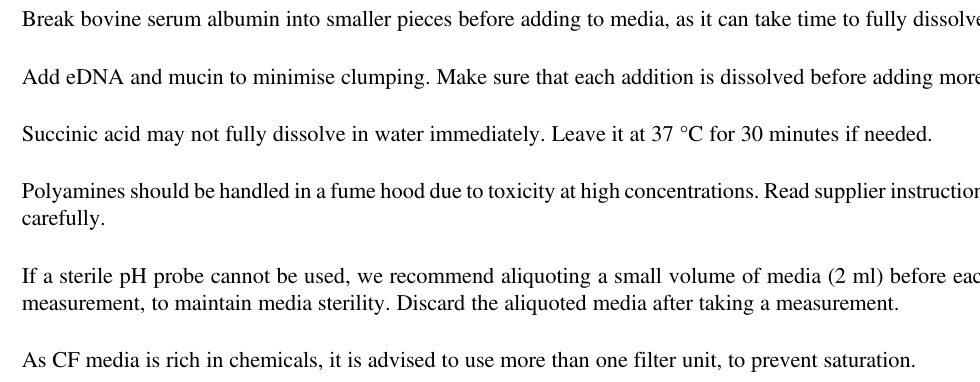
Table 13. Conditions of 5% CO 2 can be achieved by incubating the media in GasPak Jars with candles, using Campygen packs or microaerobic incubators.